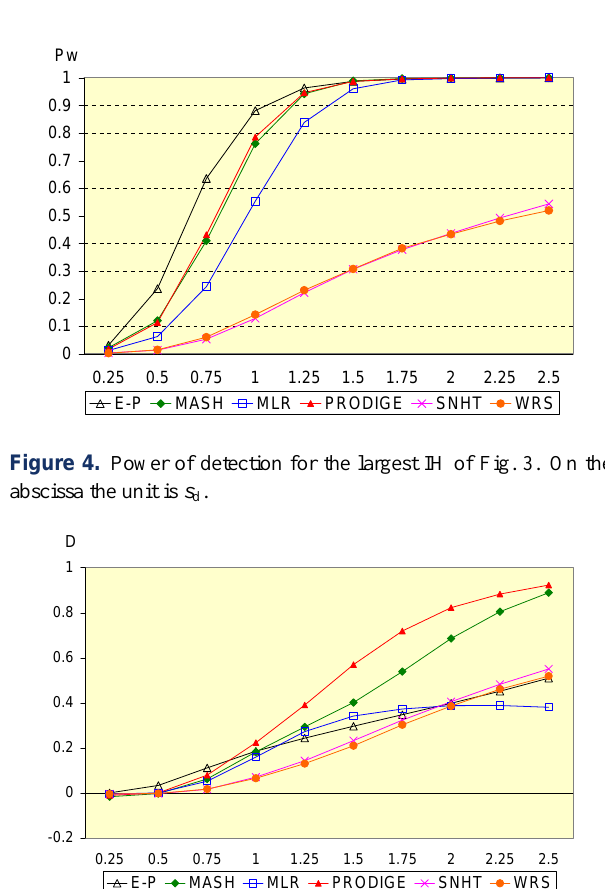
Figure 7. The same as Fig. 6, but the improvement of RMSE- error is presented on an absolute scale. ∆ (RMSE) = RMSE raw − RMSE homogenised